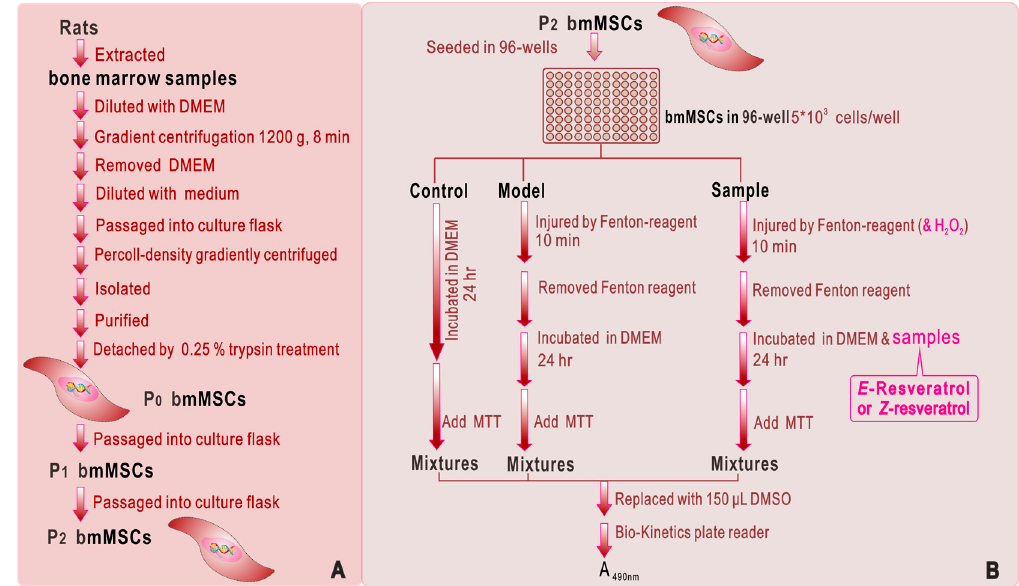
Figure 4. Experimental procedures for the preparation and culture of bmMSCs ( A ) and for the MTT assay ( B ). Each test was repeated in five independent wells. Fenton reagent: FeCl 2 (100 μ M) followed